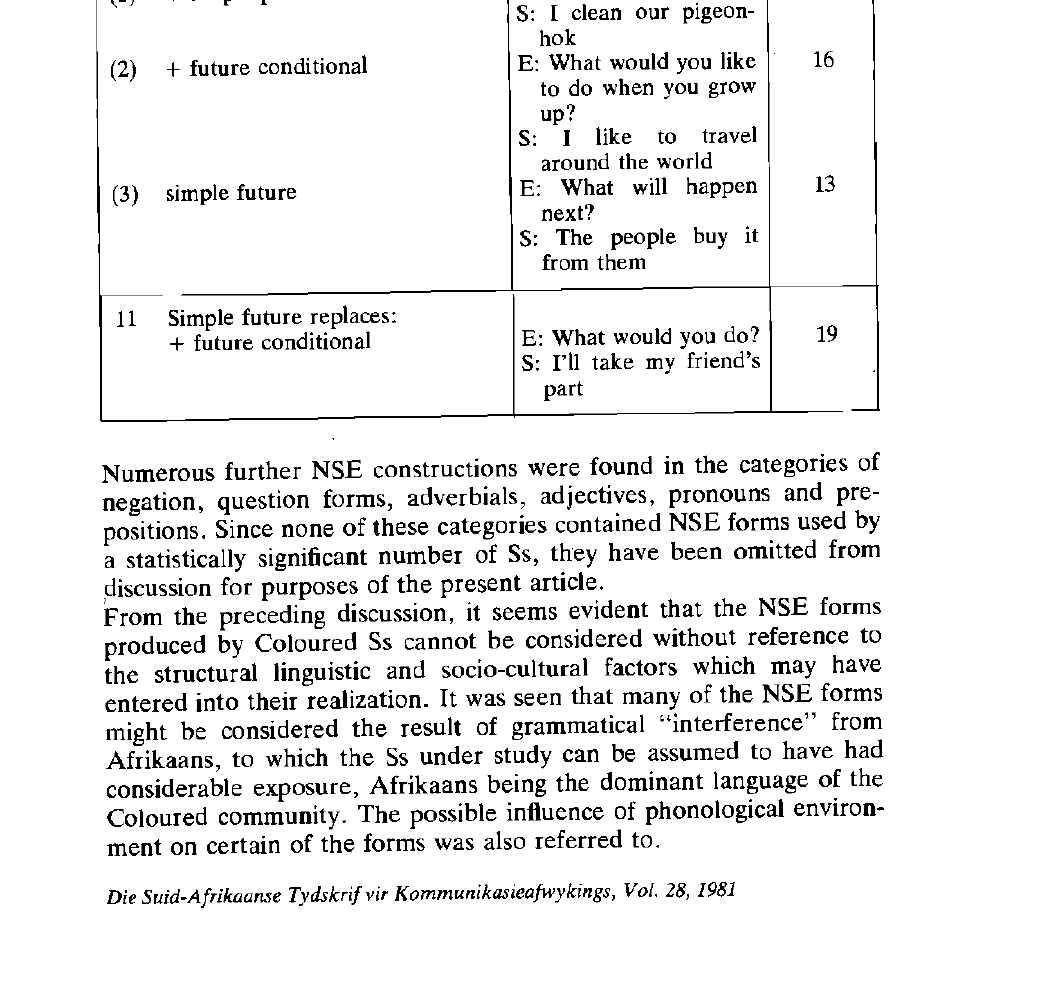
TABLE III: Non-standard tense usage in Coloured children No. Non-standard English